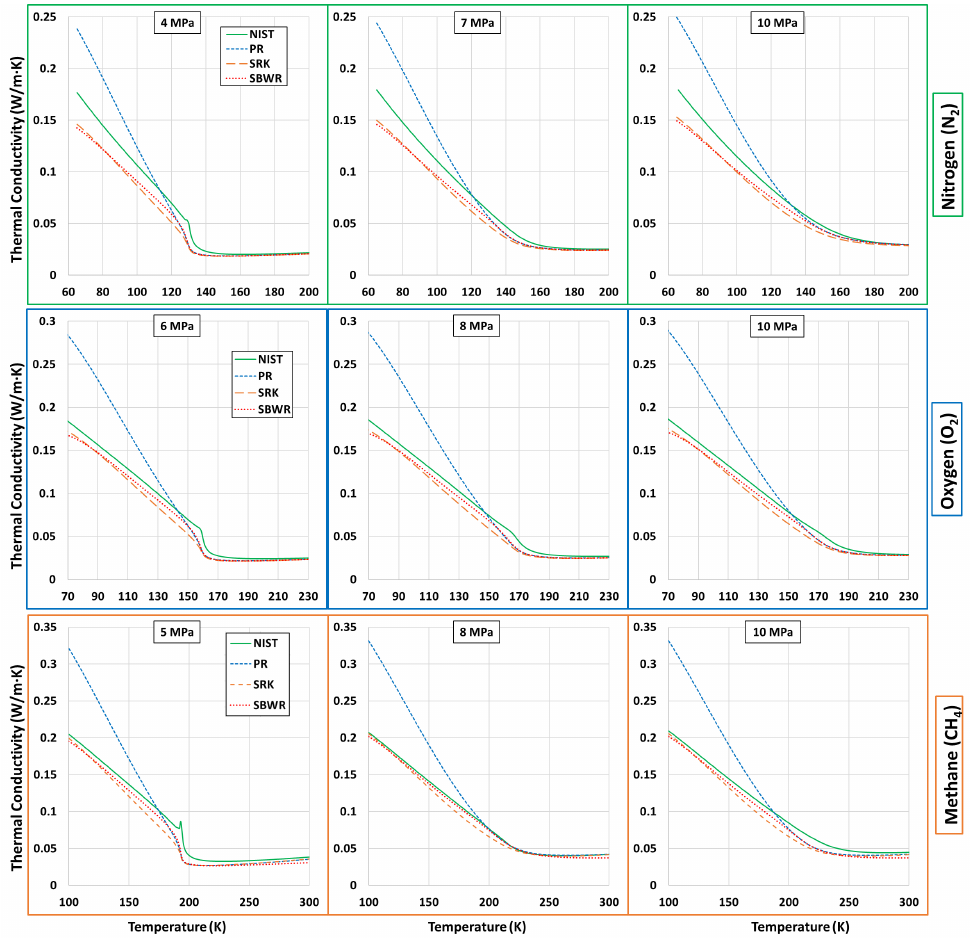
Figure 6. Plots of estimated thermal conductivity using Chung et al.’s model and density from PR, SRK and SBWR compared against NIST for cryogenic fluids (N 2 , O 2 and CH 4 ) at three supercriti- cal